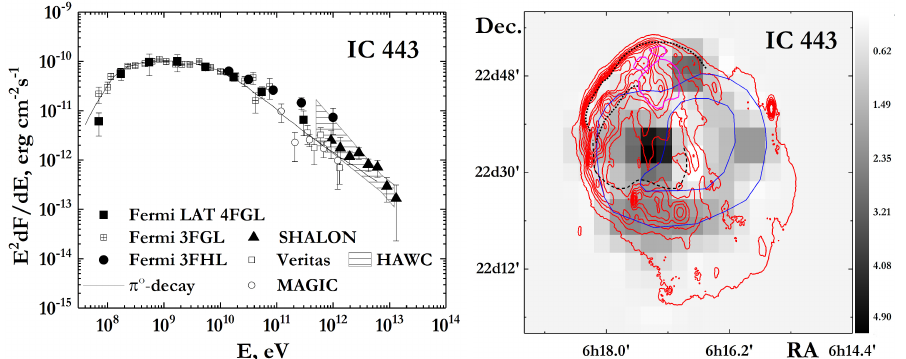
Figure 4. ( left ): Spectral energy distribution of IC 443 SNR: (cid:78) at TeV energies show the data from SHALON observations. ( right ): Emission map of SNRs by SHALON (grey scale). Red lines show Canadian Galactic Plane Survey DRAO data; magenta lines are the X-ray data by XMM-Newton, and blue lines show MeV-GeV emission regions by Fermi LAT (see text for the description). The IC 443 TeV structure by SHALON (Figure 4, grey scale) is overlaid with 1420 MHz CGPS DRAO radio contours [51] and high energy data from Fermi-LAT. The